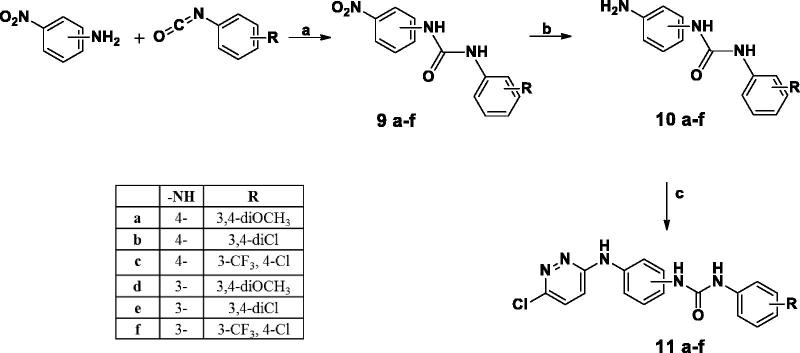
(a) Dry THF, rt, 24 h. (b) H2, Pd/C, EtOH, 120 min. (c) 3,6-dichloropyridazine, n-butanol, reflux, N2, 48 h, 35%